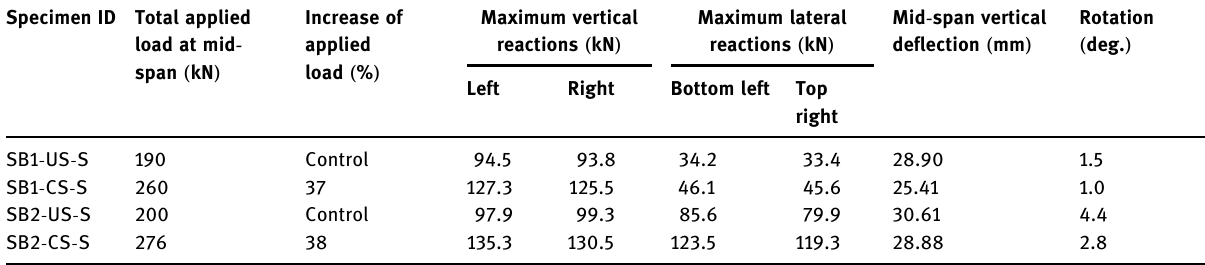
Table 3: Test results of load and displacement at failure Specimen ID Total